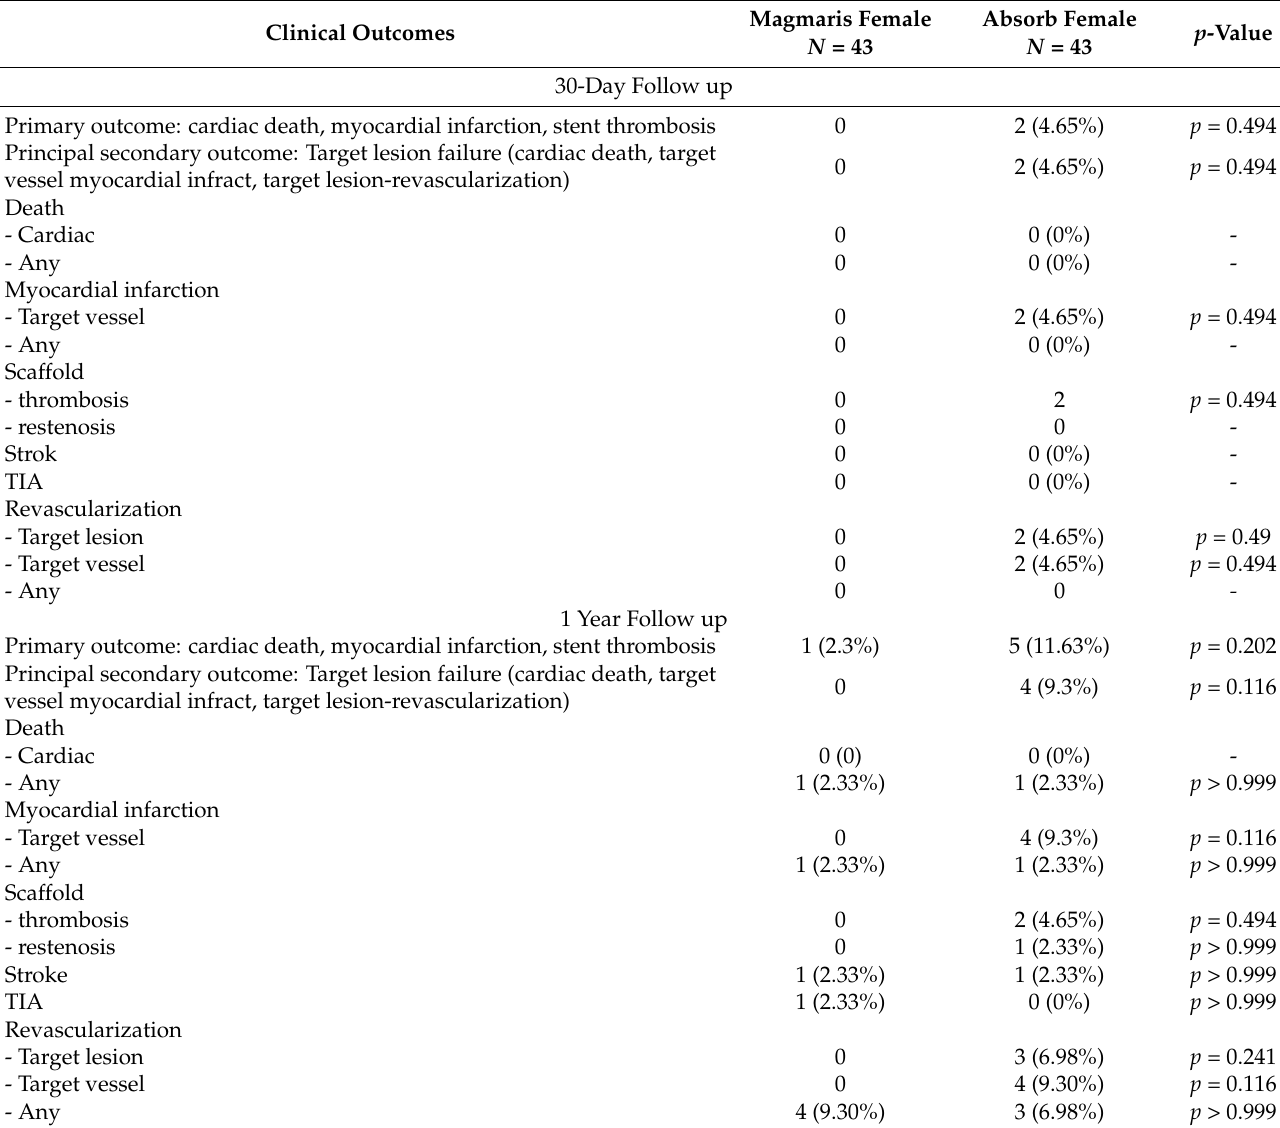
Table 4. Differences in clinical outcomes between Absorb and Magmaris female